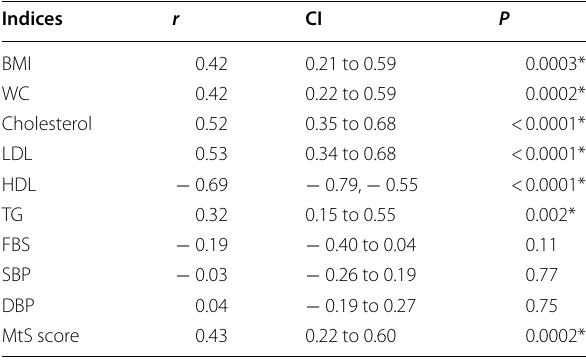
Table 4 Correlation between SGA treatment duration